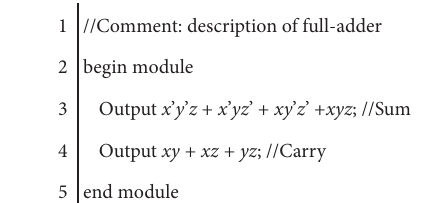
Figure 5: Example description in the input